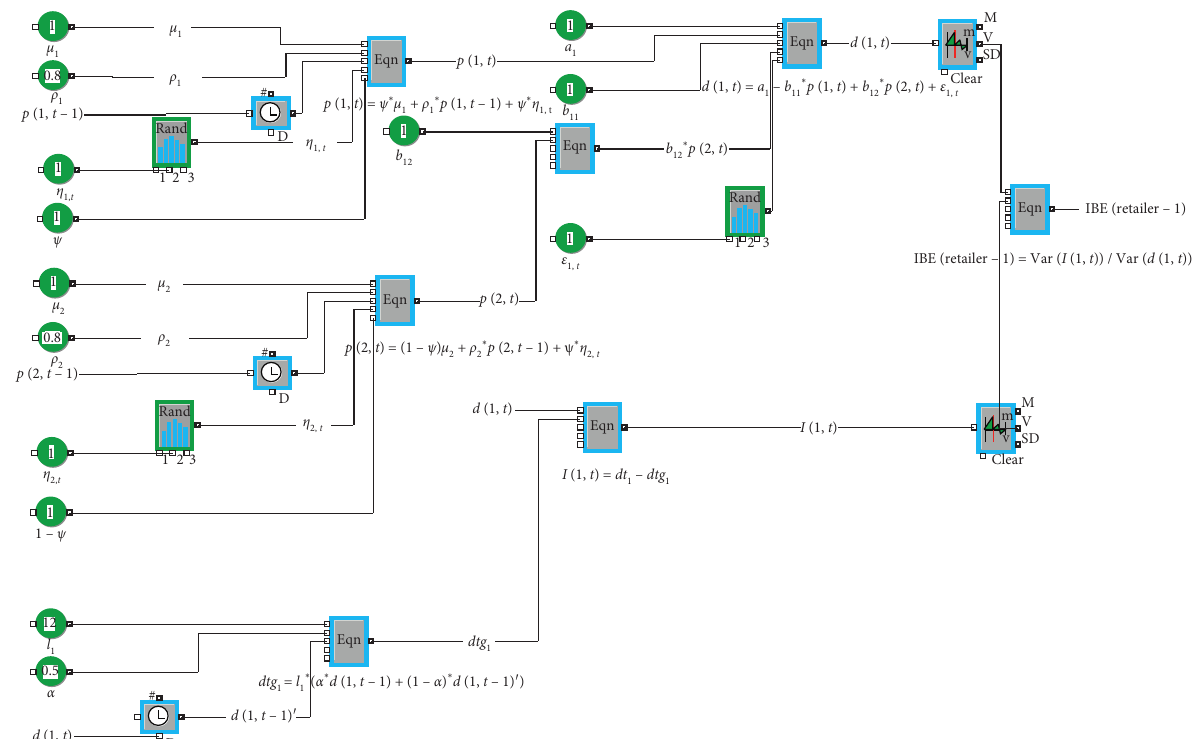
Figure 6: The simulation model of the inventory bullwhip effect based on the ES